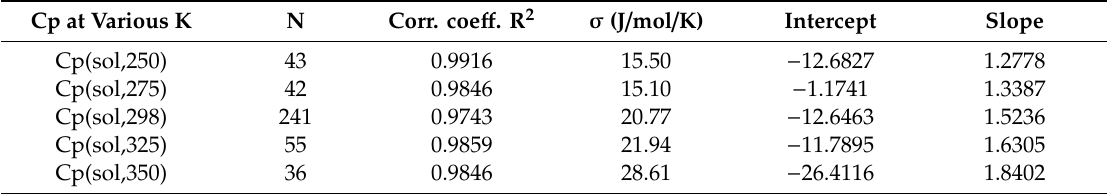
Table 17. Statistics of solid heat capacities of OH-free compounds at various temperatures. Cp at Various K N Corr. coe ff . R 2 σ (J / mol / K) Intercept Slope Cp(sol,250) 81 0.9873 19.37 8.8062 1.1569 Cp(sol,275) 83 0.9883 17.71 5.5180 1.2659 Cp(sol,298) 559 0.9760 23.66 2.6919 1.3694 Cp(sol,325) 60 0.9721 23.48 − 1.7976 1.4837 Cp(sol,350) 43 0.9711 25.59 − 5.6718 1.5794 Table 18. Statistics of solid heat capacities of OH-carrying compounds at various temperatures. Cp at Various K N Corr. coe ff . R 2 σ (J / mol / K) Intercept Slope Cp(sol,250) 43 0.9916 15.50 − 12.6827 1.2778 Cp(sol,275) 42 0.9846 15.10 − 1.1741 1.3387 Cp(sol,298) 241 0.9743 20.77 − 12.6463 1.5236 Cp(sol,325) 55 0.9859 21.94 − 11.7895 1.6305 Cp(sol,350) 36 0.9846 28.61 − 26.4116